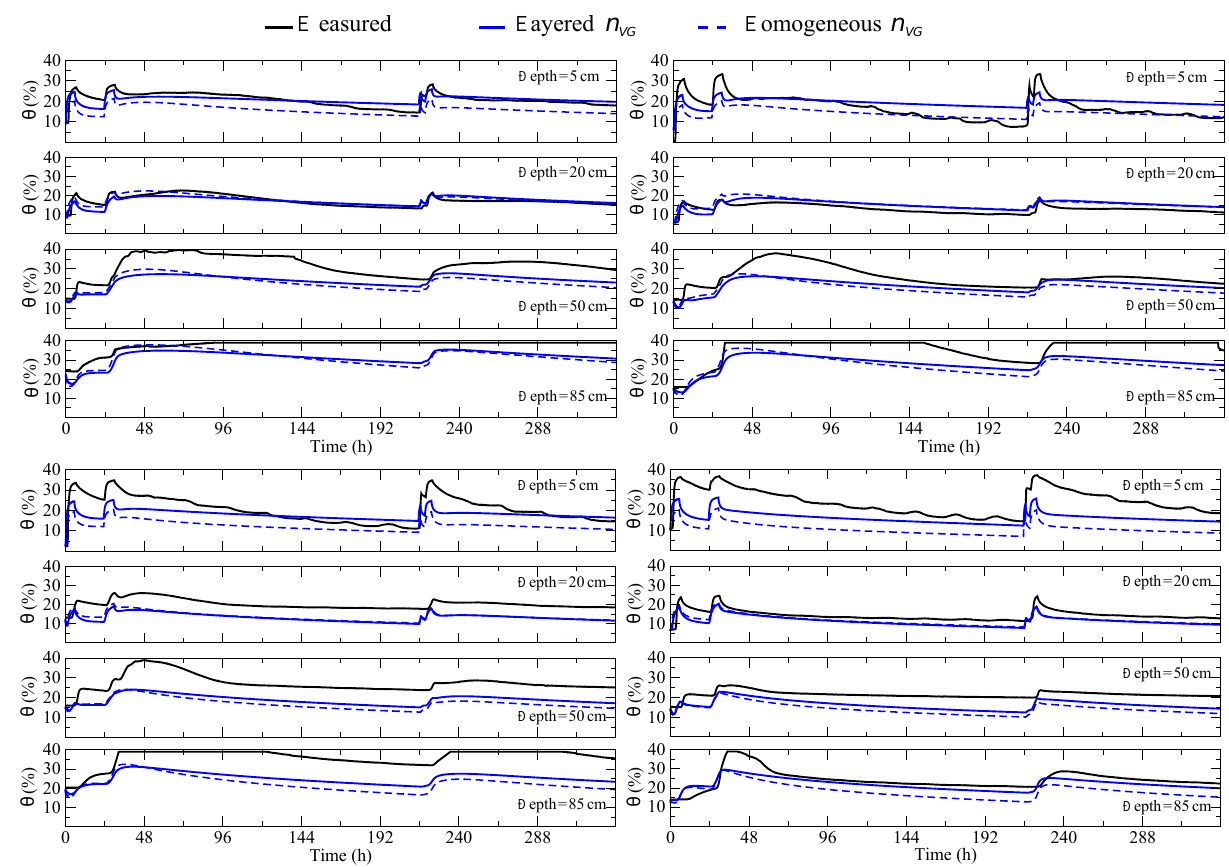
Figure 13. Distributed (internal state) hydrological response for the θ profiles at 5, 20, 50, and 85cm depths from the surface for four locations on the LEO-1 hillslope: point a (top left), point b (top right), point c (bottom left), and point d (bottom right) of Fig. 2. The results are obtained for simulations f and l reported in Table